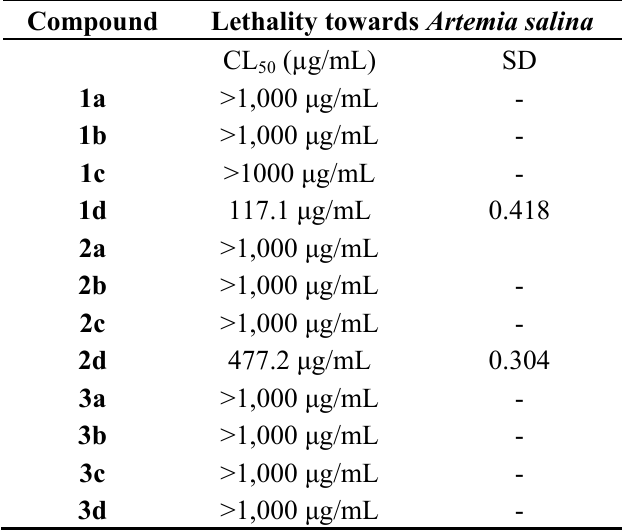
Table 2. Cytotoxicity evaluation by the brine shrimp test of triterpene acid